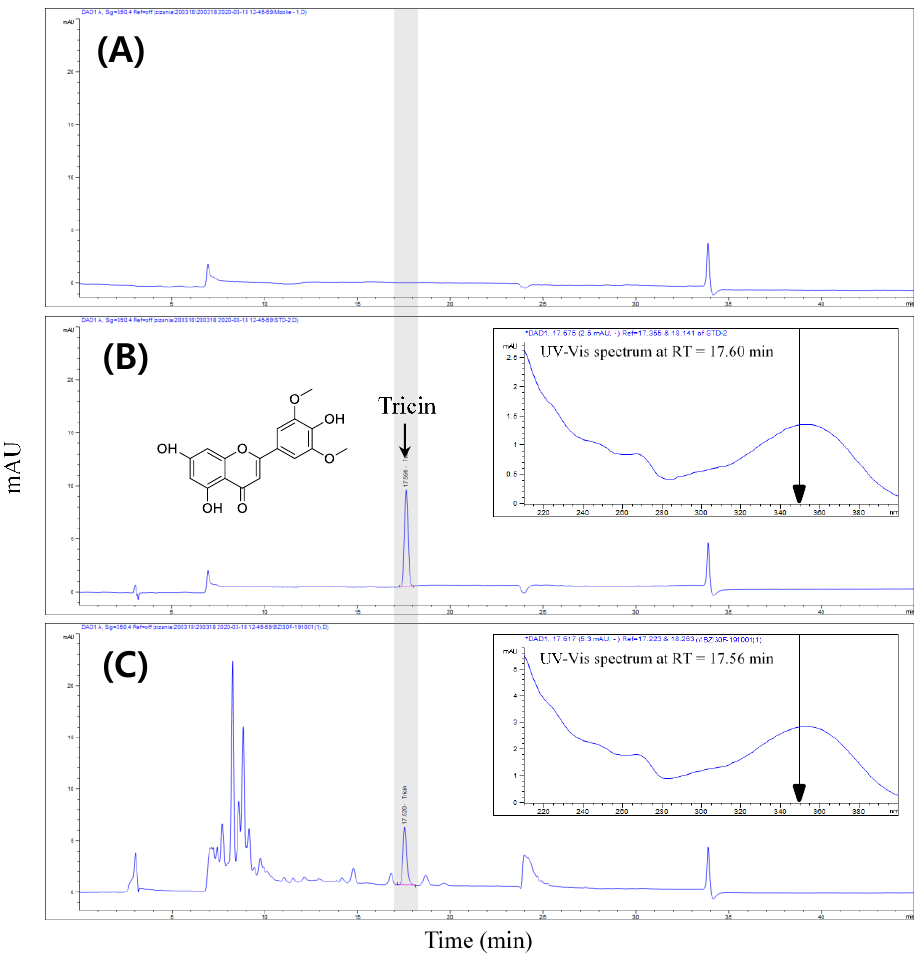
Figure 1. HPLC chromatographic profiles of ( A ) blank, ( B ) tricin standard, and ( C ) enzyme-treated Z. latifolia extract (ETZL) with excitation at 350 nm.